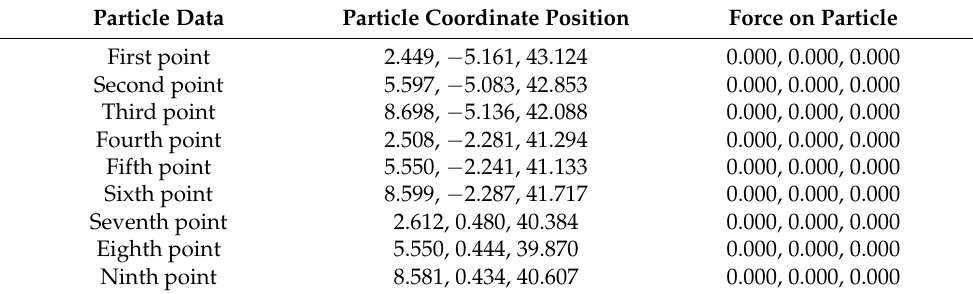
Table 2. Initial position and stress of particle.